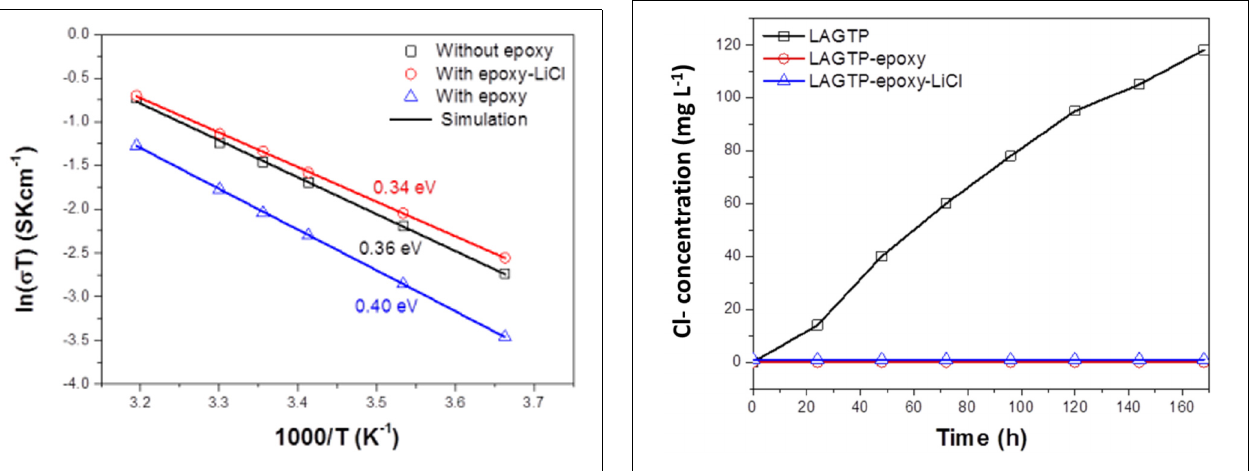
FIGURE 6 | Water permeation of LAGTP, LAGTP-E, and LAGTP-E-LiCl at room